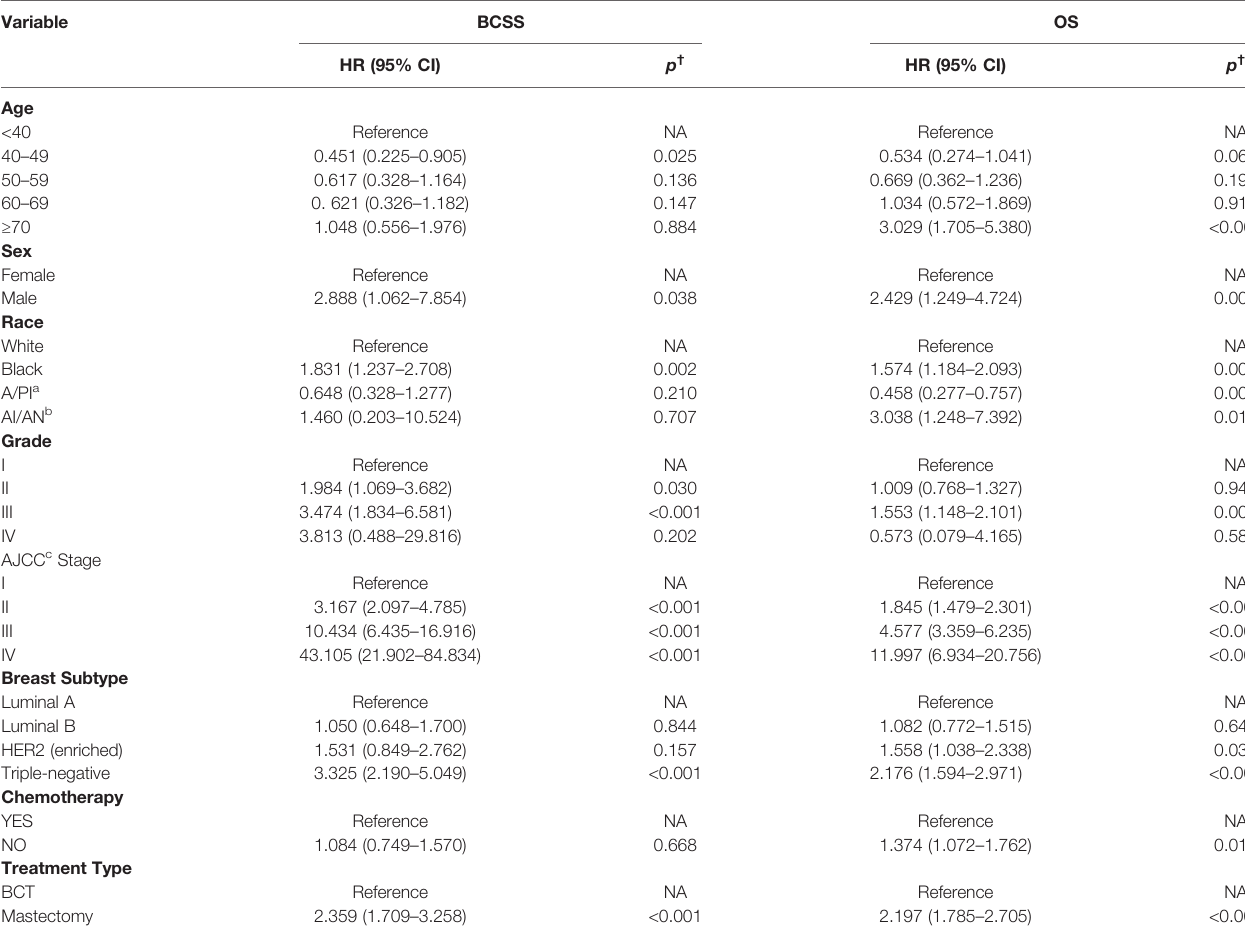
TABLE 3 | Multivariable Cox proportional hazard regression model of breast cancer-speci fi c survival (BCSS) and overall survival (OS).